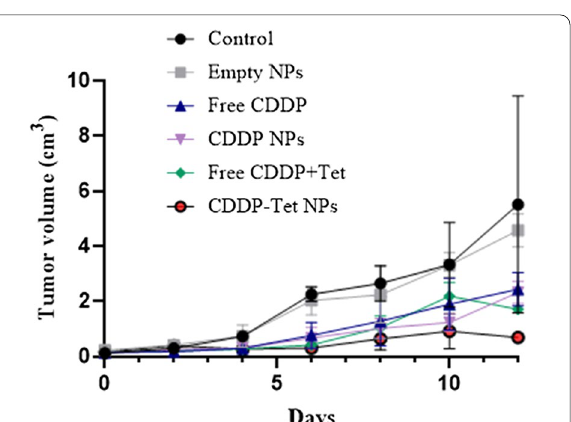
Fig. 6 Tumor volume of established H 22 xenografts in ICR mice during therapy under different treatments. Mice were treated with different strategies on day 0 as shown in the figure: 3 mg/kg of free CDDP, free CDDP together with Tet (CDDP 3 mg/kg Tet 7.2 mg/ + kg), and CDDP-Tet-loaded NPs (CDDP 3 mg/kg Tet 7.2 mg/kg), + respectively. Mean SD ( n 6) of each group was ± =